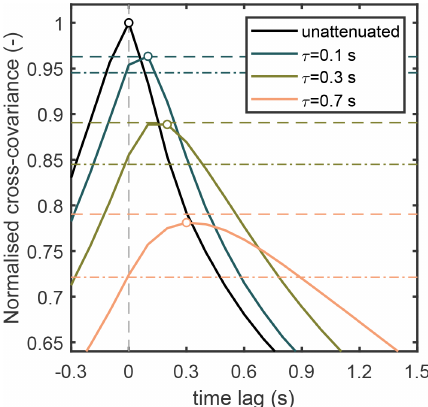
Figure 3. Cross-covariance between w and ˆ T calculated from data measured between 09:30 and 11:30 on 16 June 2013 at the Si- ikaneva site. T data were attenuated with Eq. (3) and three different values for τ in order to demonstrate the effect of filtering on cross- covariance. All the cross-covariance values were normalised with a maximum of unattenuated cross-covariance (i.e. unattenuated co- variance). Dots highlight the maxima. Horizontal dashed lines show the attenuation factor (inverse of correction factor, 1 / CF) values cal- culated with Method 4, and dash-dot lines show the attenuation fac- tors calculated with Method 1. Note that the dash-dot lines match the cross-covariance values at zero lag, whereas dashed lines agree with the cross-covariance